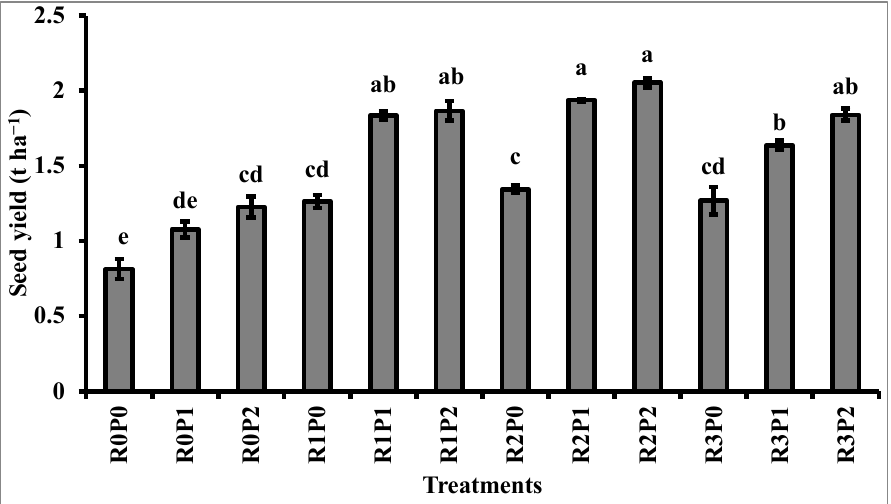
Figure 3. Interaction effect of Rhizobium japonicum and Pseudomonas striata on seed yield of soybean, (mean ± SE, n = 3); R 0 : Control (no nitrogen and R. japonicum ), R 1 : 100% N without R. japonicum , R 2 : 50% N with R. japonicum , R 3 : only R. japonicum inoculant, P 0 : Control (no P and no P. striata ), P 1 : 100% P without P. striata and P 2 : 75% P with P. striata . Mean values sharing similar letters are statistically insignificant. Two-way ANOVA showed a significant interaction ( p ≤ 0.05) between R. japonicum and P. striata